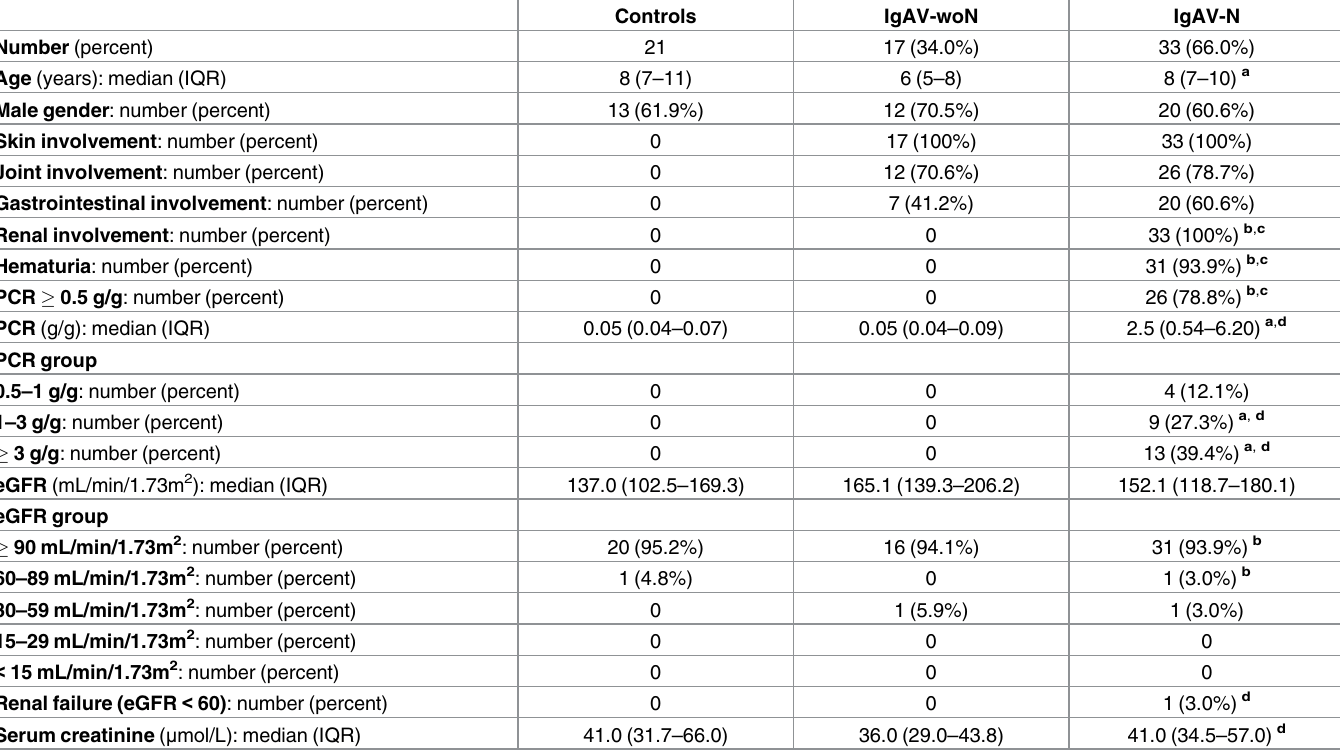
Table 1. Patient characteristics.